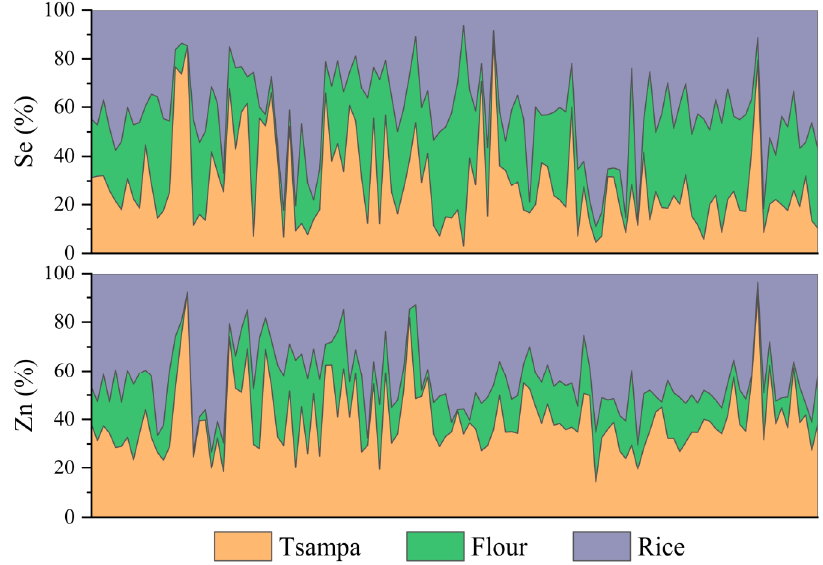
Figure 5. Staple grains contribution to Se and Zn intakes.